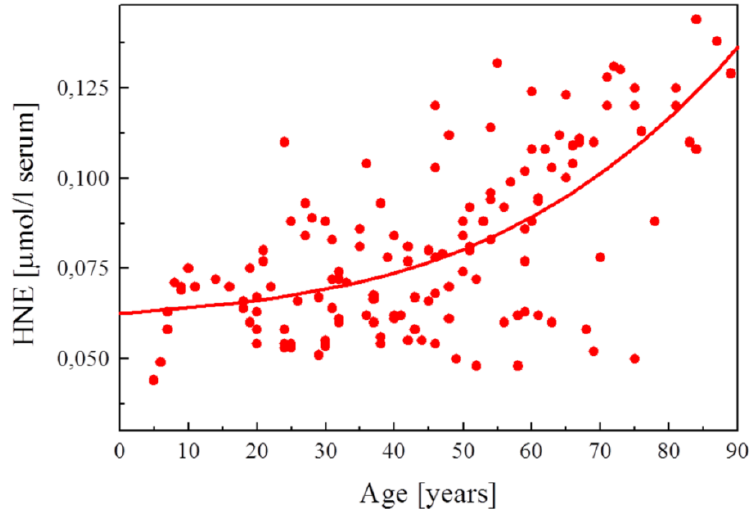
Figure 5. HNE plasma concentration in dependence on age of the blood donor (5 to 90